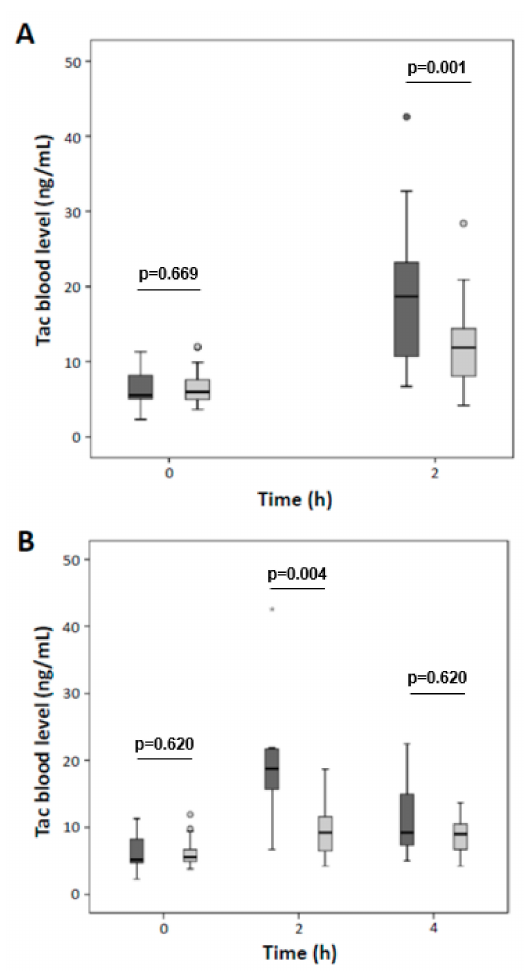
Figure 4. Presented are C0, C2 ( n = 56) ( A ), and C4 ( n = 25) ( B ) Tac levels in stable kidney transplanted patients. While the trough level (C0) and the C4 level were comparable between patients with a high (dark grey bars) and low (light grey bars) C / D ratio, C2 levels were significantly increased in patients with a low C / D